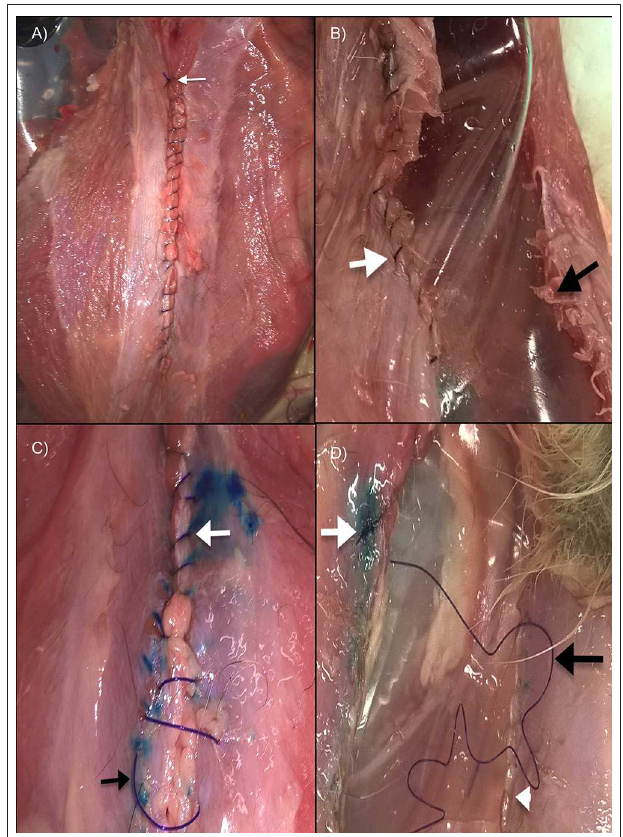
FIGURE 4 | (A) Failure distant from celiotomy closure in a 2 × 2 SBSI cranial celiotomy. White arrow is at the suture line. (B) Failure by fascial tearing in a 2 × 2 SBSI cranial celiotomy. Notice cracks at the site of needle penetration (black arrow) with the suture line remaining intact (white arrow). (C) Failure by slacking (loss of suture line tension) at the caudal part of celiotomy closure (black arrow) while the cranial part of the closure (white arrow) still remains intact. (D) Same specimen at the end of the test showing as pressure increases complete loss of suture line tension occurs (black arrow) with the knots remaining intact (white arrow). White arrowhead is at the sites of needle